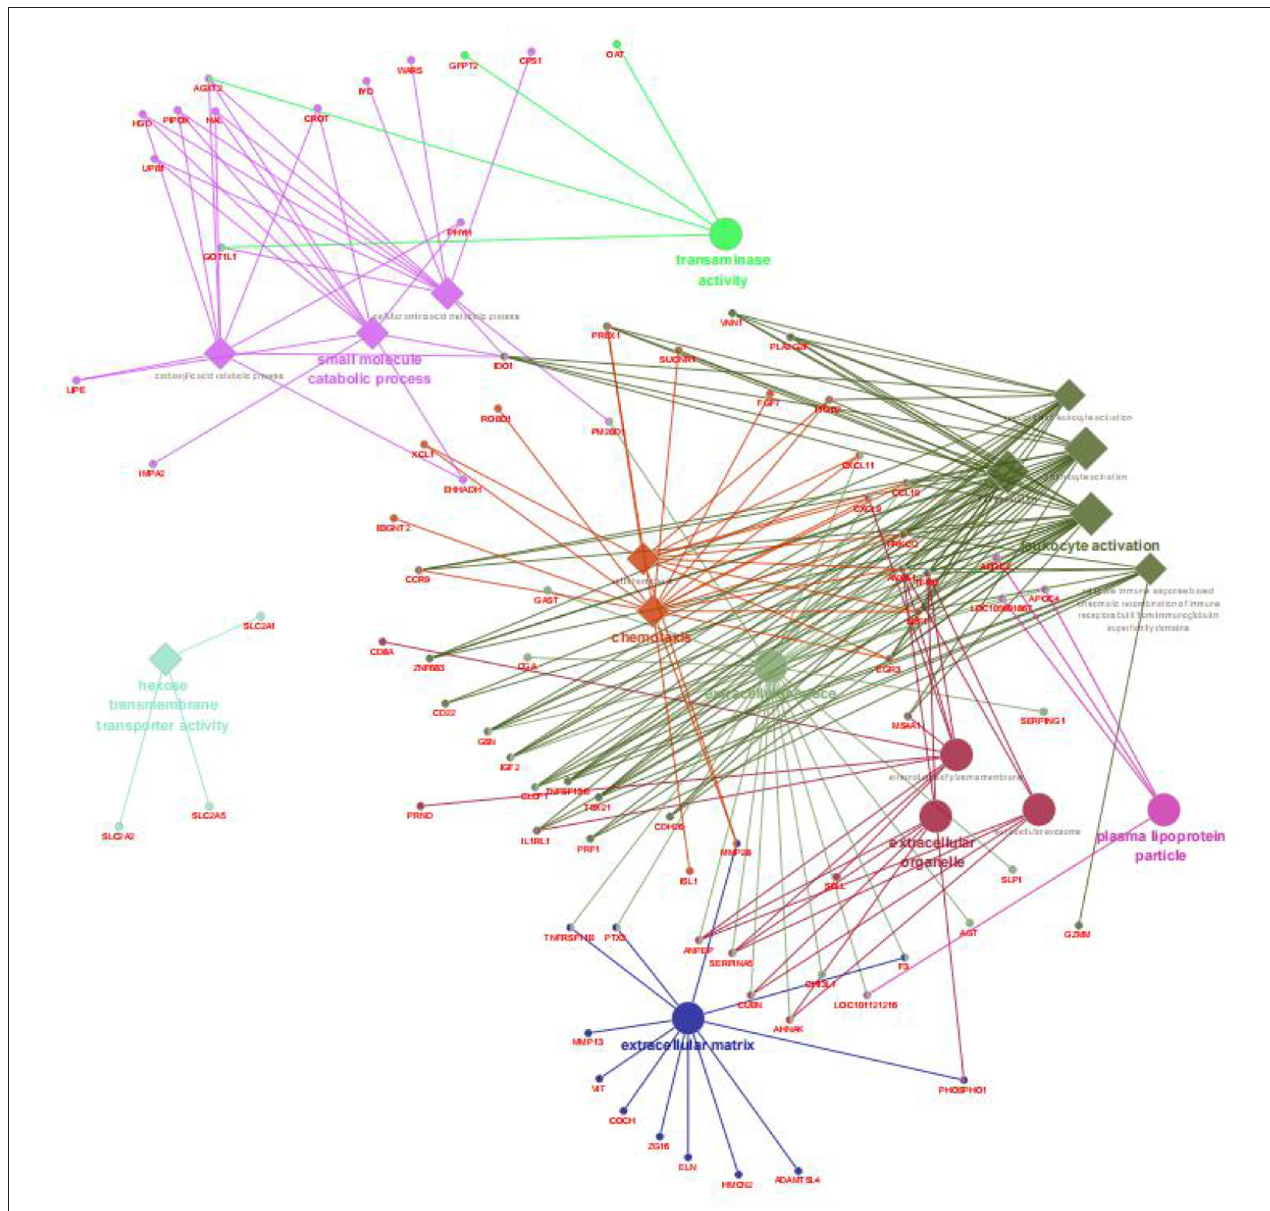
FIGURE 3 | Enriched biological processes, cellular components, and molecular functions assigned to the DEGs between the AR and ER groups. The diamond showed the biological processes; the big circle showed the cellular components; the small circle showed the genes; the different colors represented the different functional groups, respectively, based on kappa score; all the DEGs were not enriched molecular functions. proteome were increased in the functions of immunoglobulin- mediated immune response, Staphylococcus aureus infection, and negative regulation of leukocyte differentiation. Meanwhile, the genes having the same downregulated trend in transcriptome and proteome were enriched in the PPAR signaling pathway ( APOA2 , APOC3 , ACSL3 , CPS1 , FABP2 , and PCK1 ), intestinal lipid absorption ( APOA2 , FABP2 , and CEL ), urea cycle ( CPS1 , PCK1 , SLC25A15 , and ASS1 ), and ferroptosis ( ACLS3 , CP , and TFRC